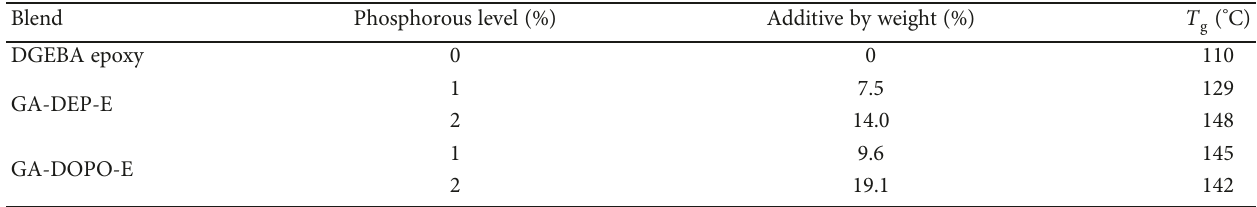
Table 3: Glass transition temperatures for blends of phosphorus esters of gallic acid anilide with DGEBA epoxy resin. Blend Phosphorous level (%) Additive by weight (%)